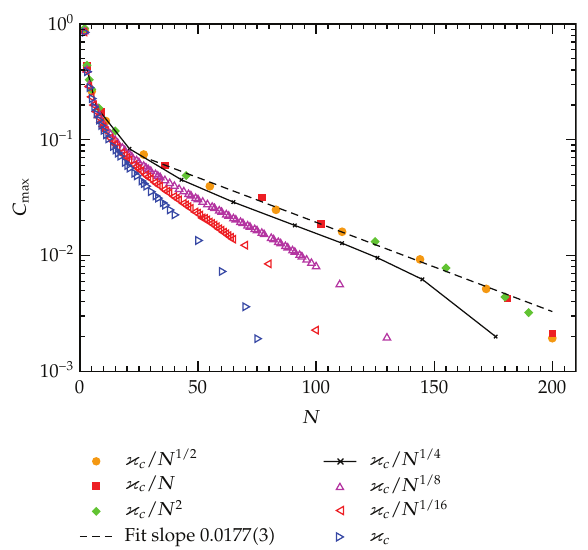
Figure 5: Maximal concurrence as a function of the number of spins, for di ff erent power law scaling, as (cid:4) | k | , p (cid:8) 0 . 5, v (cid:8) 0 . 48, (cid:9) (cid:8) ν c /ν T (cid:8) 1, T (cid:8) 300K, κ c (cid:8) 0 . 2. The indicated in the legend. Here is f c (cid:2) k (cid:3) (cid:8) dashed line indicates a fitting exponential for the cases η > 1 / 4. The solid curve indicates the case, η (cid:8) 1 / 4.